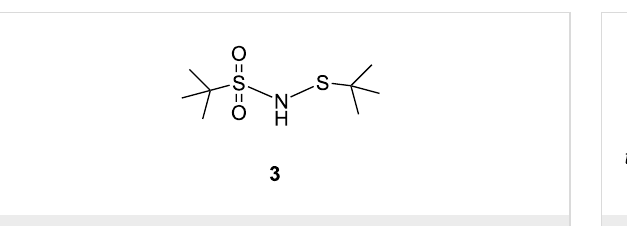
Scheme 4: Synthesis of tert